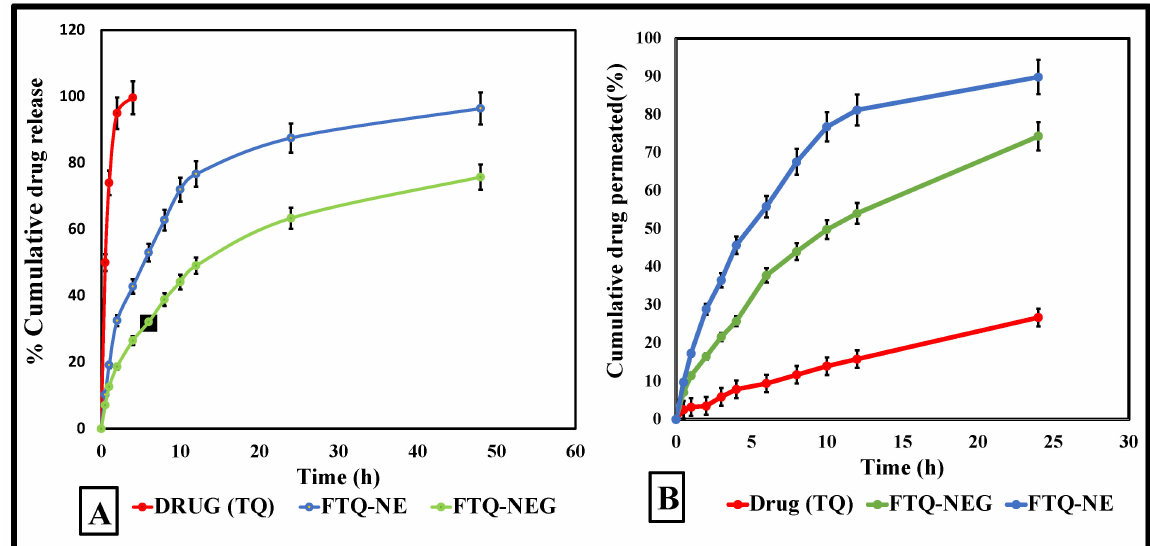
Figure 11. ( A ) In vitro drug release of TQ, FTQ-NE, and FTQ-NEG. ( B ) The ex vivo skin permeation release of the free drug TQ, FTQ-NEG, and